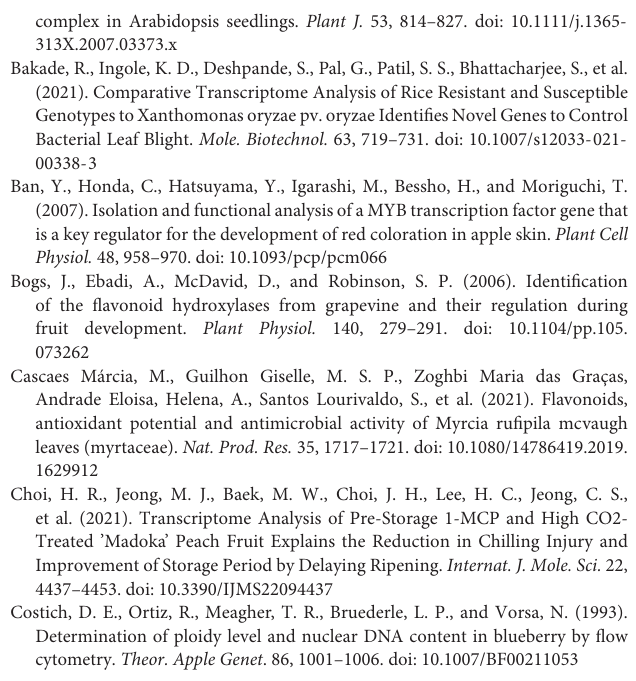
Supplementary Table 3 | List of primers used in this study. Supplementary Table 4 | Comparison of flavonoid synthesis-related genes in